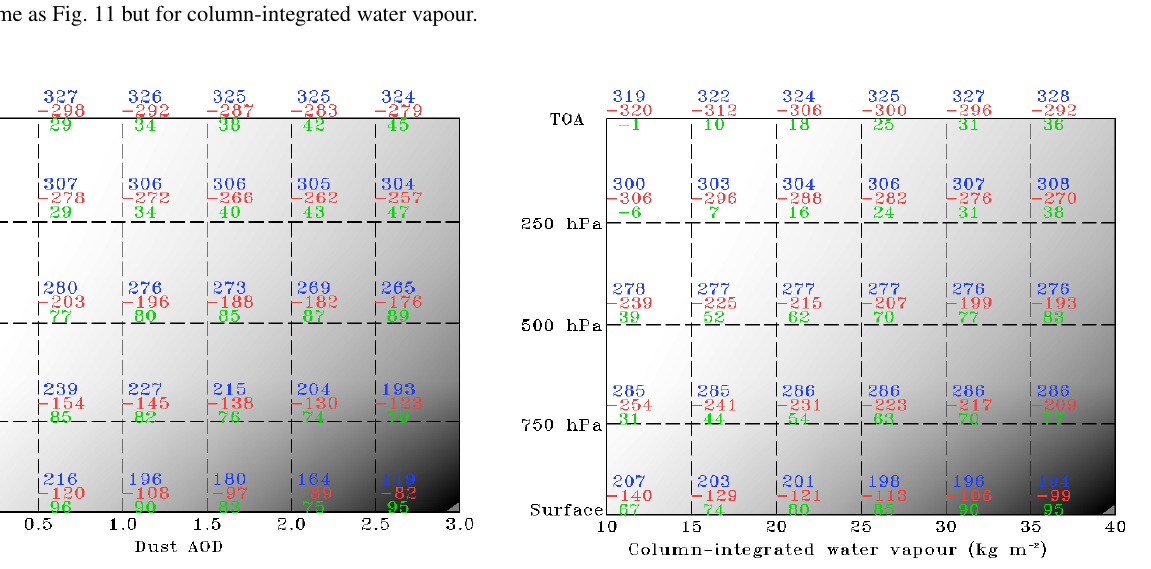
Figure 16. Sensitivity of radiative flux (Wm − 2 ) to changes in dust AOD. The numbers at each pressure level are downward shortwave (blue), longwave (red), and net (green) fluxes. The grey shade rep- resents dust and water vapour amount in the atmosphere.